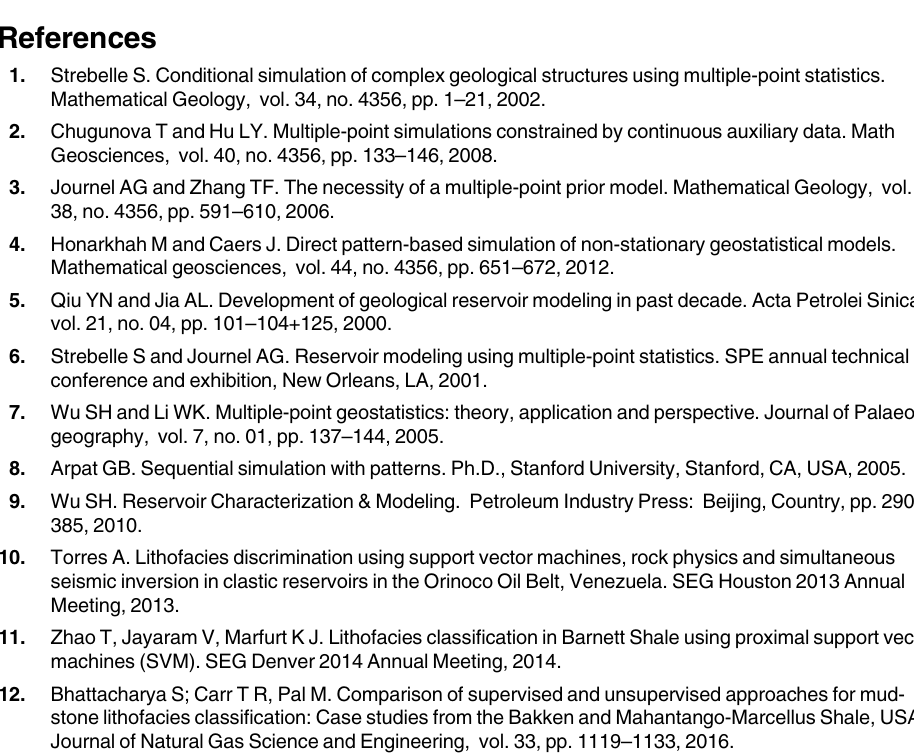
S1 Fig. High resolution figures. All Figures of the whole paper along with extra figures are